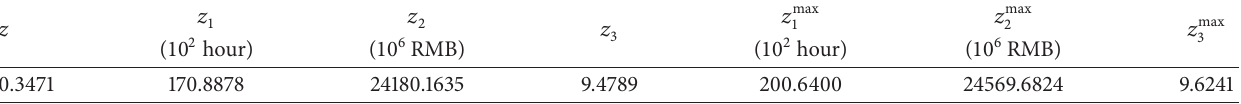
Table 8: Results of multiple objectives values using the CP-based HPSO algorithm for MRCMPSP.